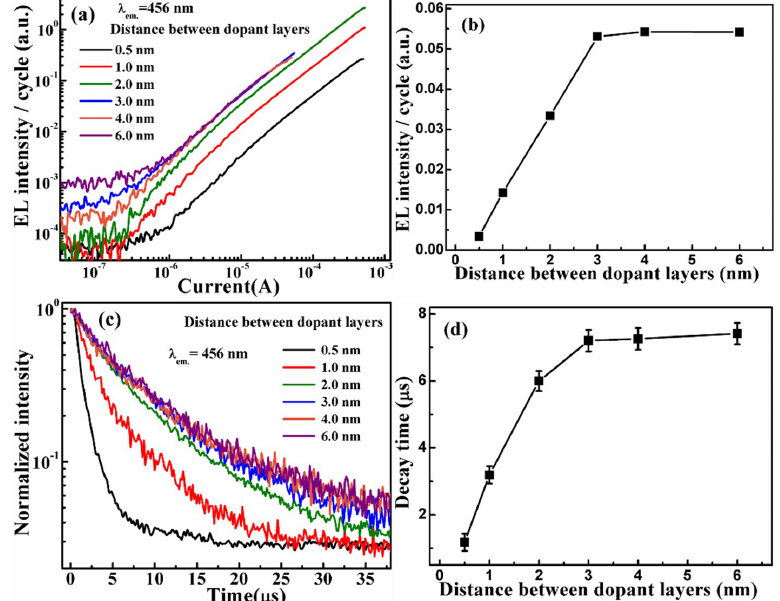
Figure 6. ( a ) The dependence of the blue EL intensity on the injection current from the Al 2 O 3 /Tm 2 O 3 MOSLEDs with different Al 2 O 3 sublayer thicknesses. Here, the EL intensities are divided by the cycle numbers to present the emissions from every Tm dopant cycle. ( b ) The relation of blue EL intensity with the Al 2 O 3 sublayer thicknesses. ( c ) The EL decay lifetime for the Al 2 O 3 /Tm 2 O 3 MOSLEDs and ( d ) the relation of lifetime to the Al 2 O 3 sublayer